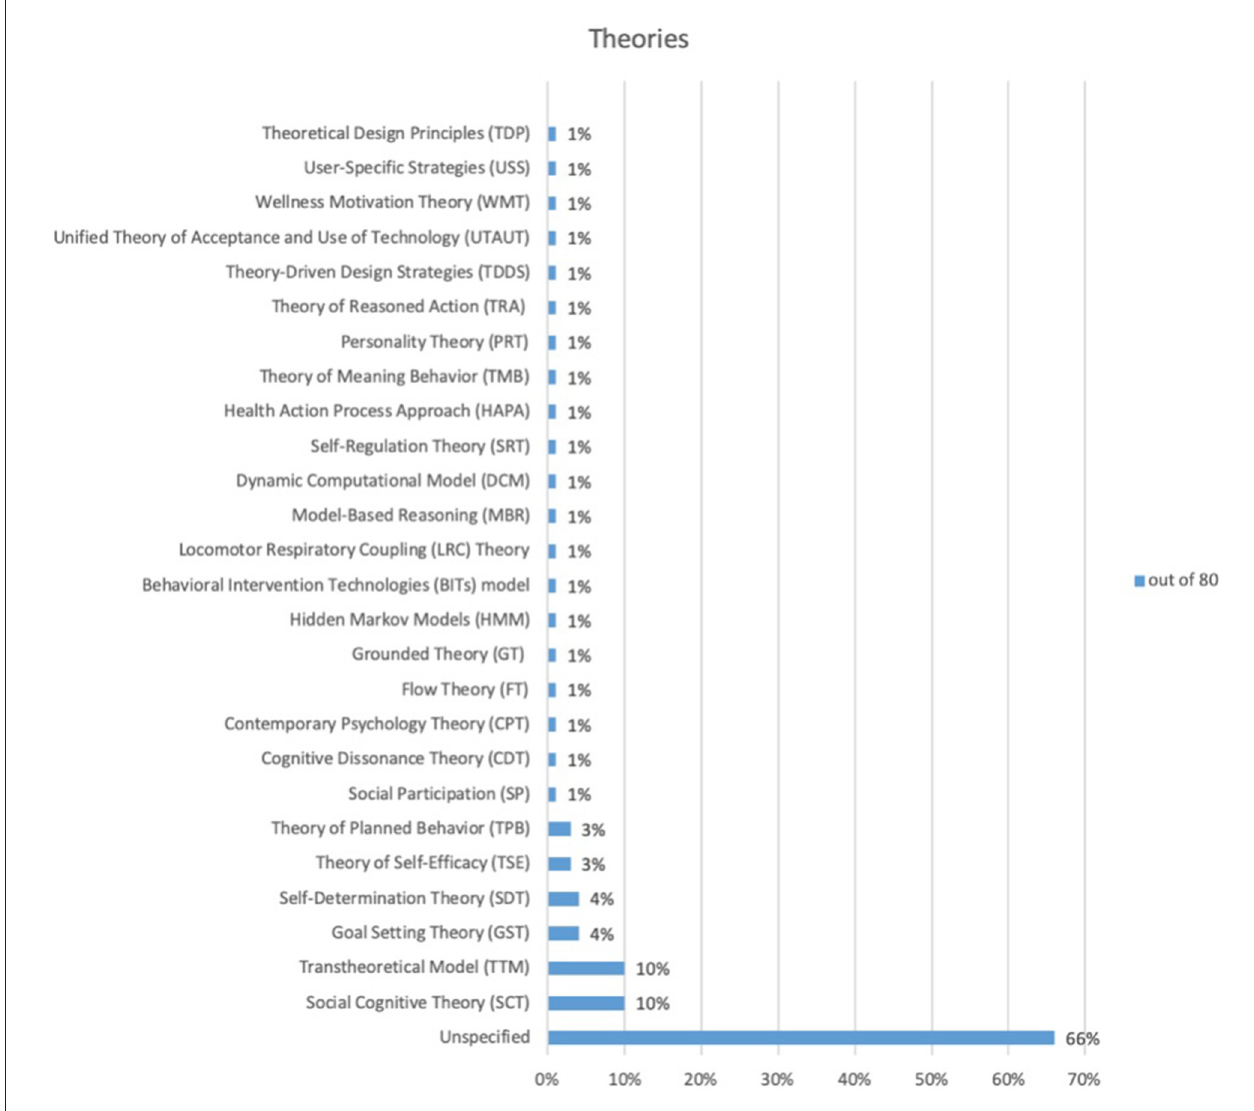
FIGURE 9 | Behavior theories used in mobile phone-based persuasive technology